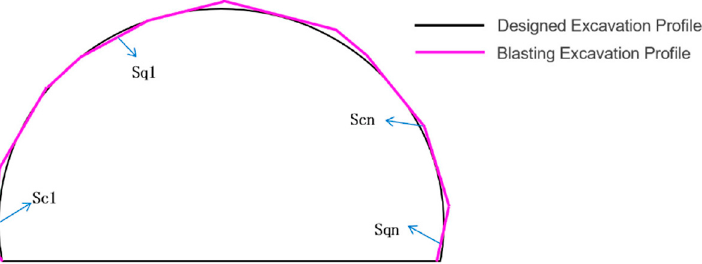
Figure 4. Schematic diagram for the calculation of average overbreak and underbreak.